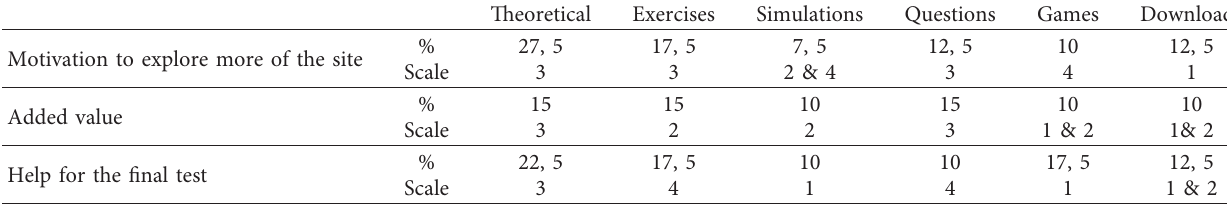
Table 2: Student opinions on the links on the